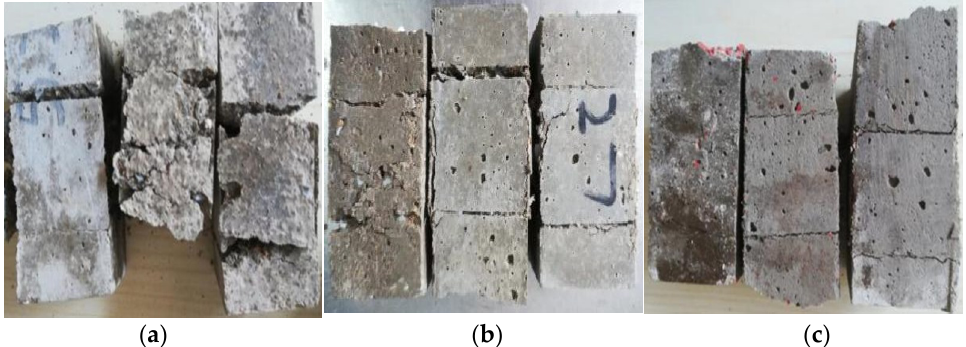
Figure 10. Failure modes of the mortar specimen in the compressive test, ( a ) plain ( b ) 5 mesh silicone rubber, 15% content, and ( c ) 5 mesh silicone rubber, 30% content.